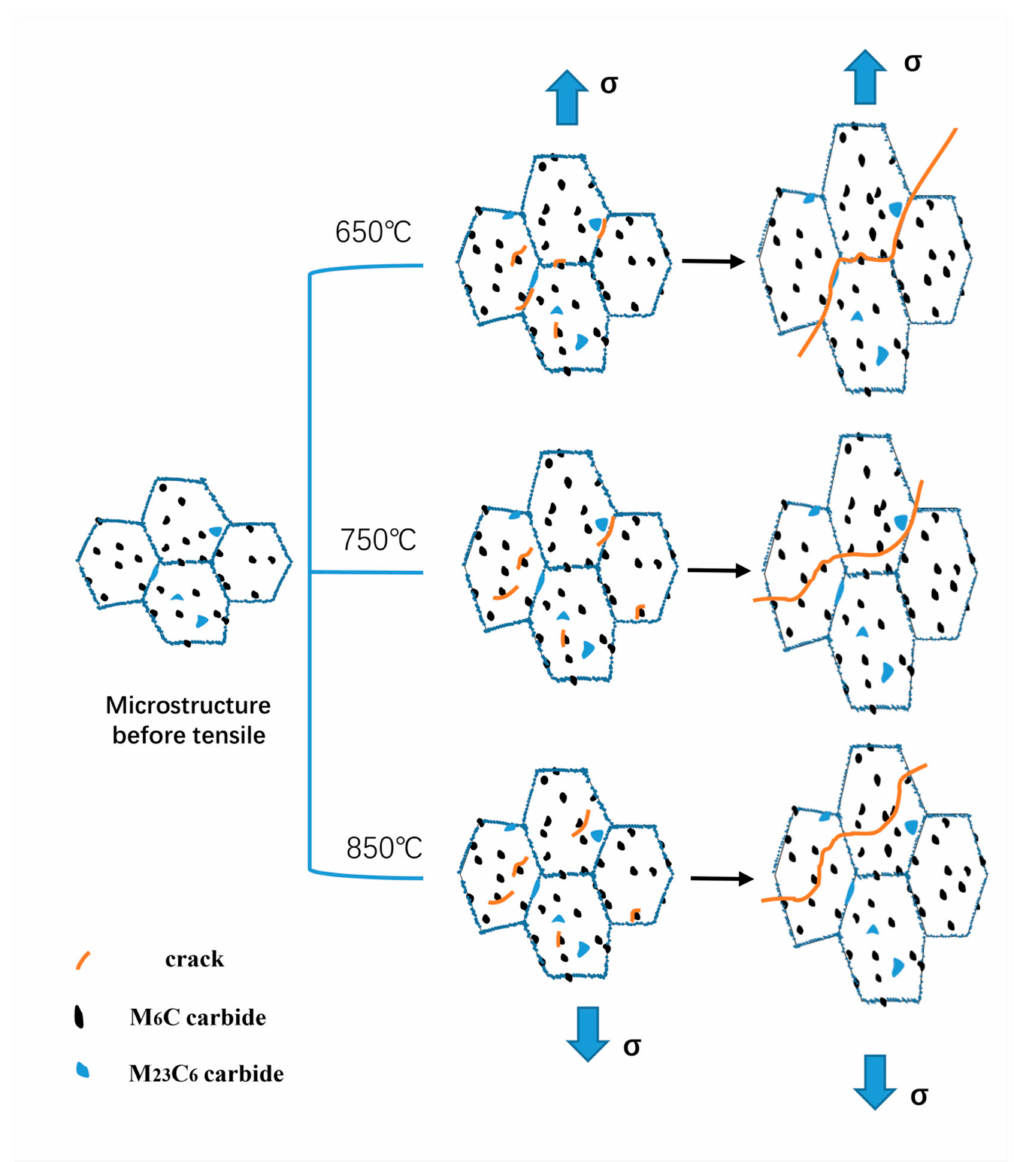
Figure 9. The schematic of the microstructure evolution and fracture mechanism of the tested alloy at di ff erent